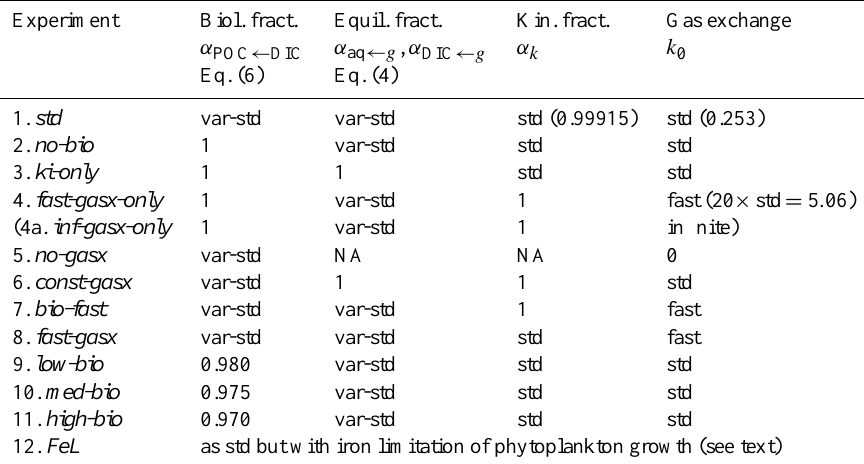
Table 1. Sensitivity experiments. Note that 4a is not a numerical experiment but the results were calculated using simulated temperature as described in the